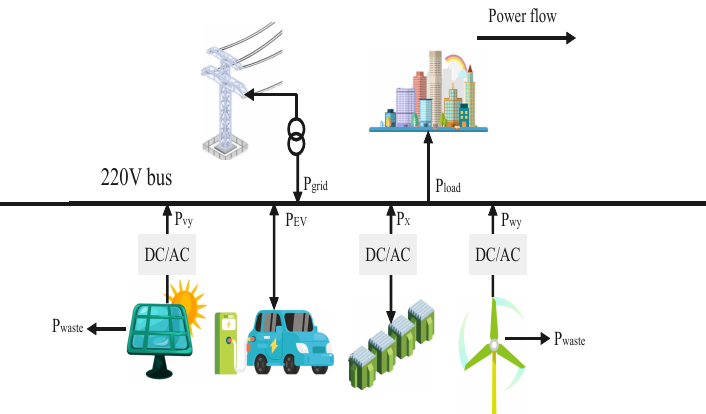
Figure 1. The model of wind–solar-storage electric vehicle microgrid